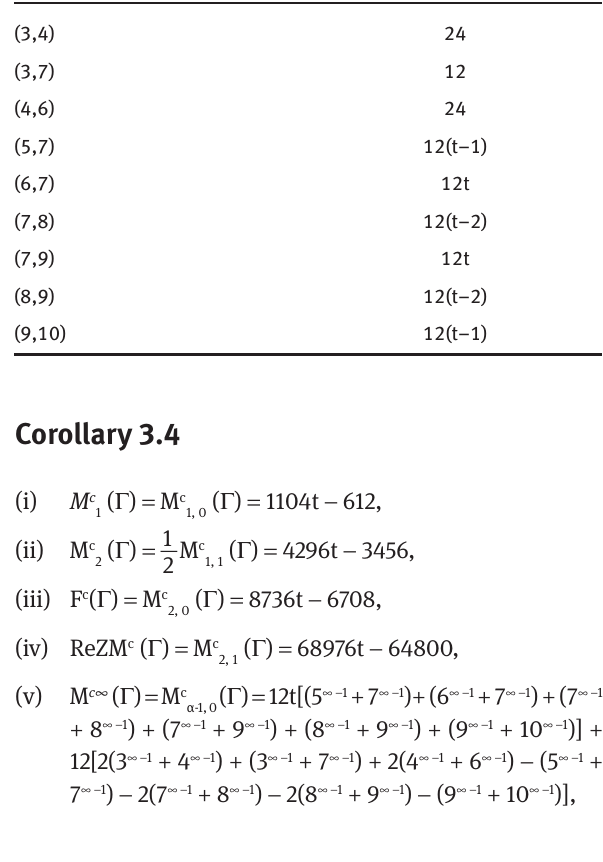
(t) that is based on 2